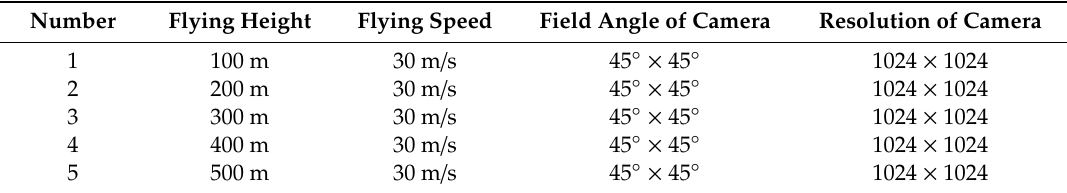
Table 1. The simulation conditions.